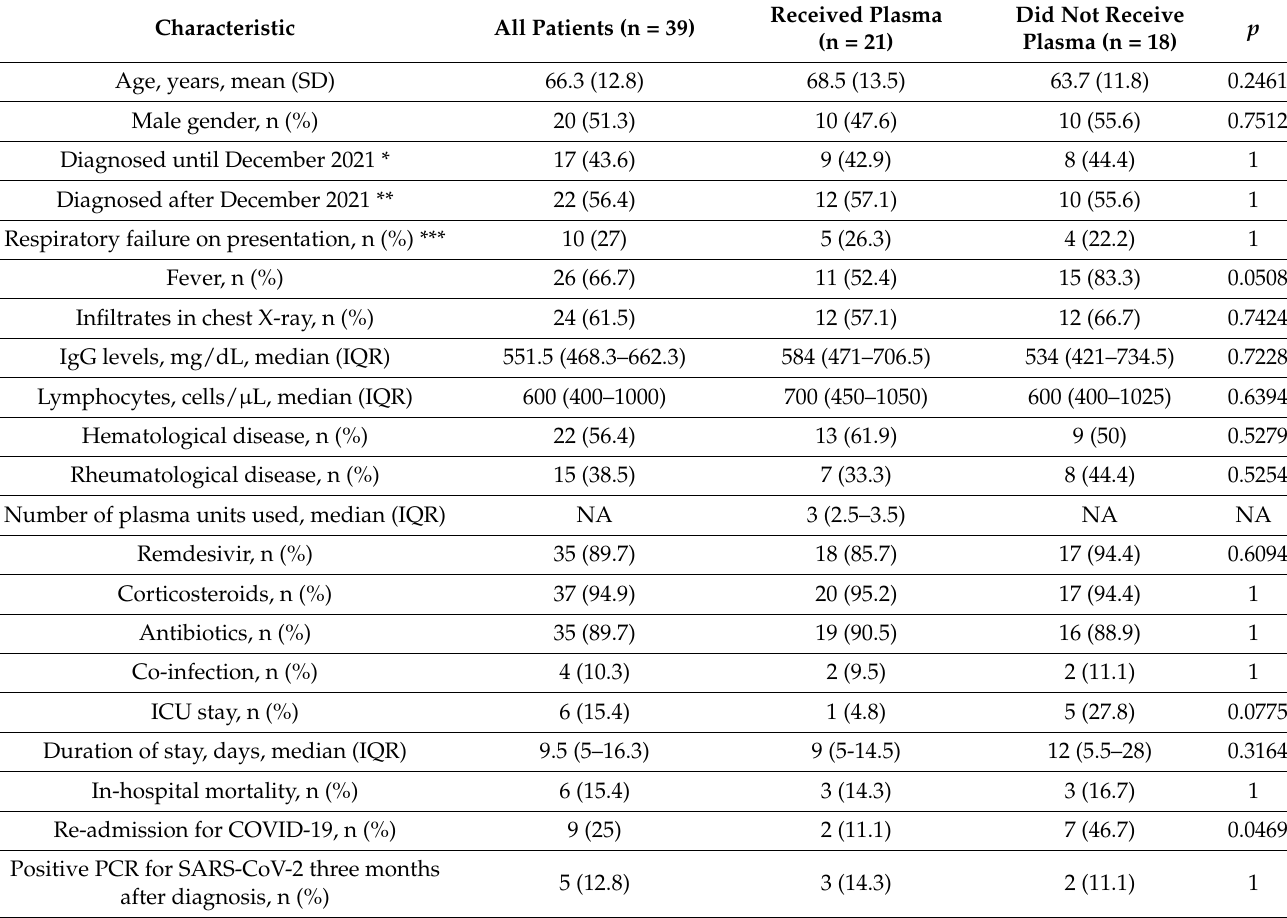
Table 1. Patients’ characteristics in total and in regard to whether they received treatment with